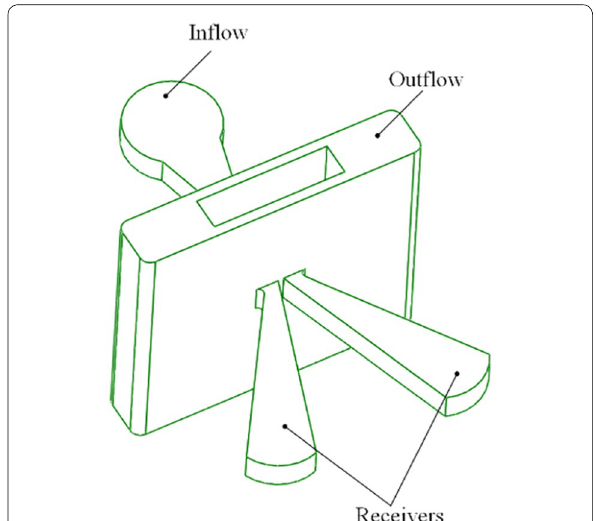
Figure 8 Deflector jet structure’s 3D model